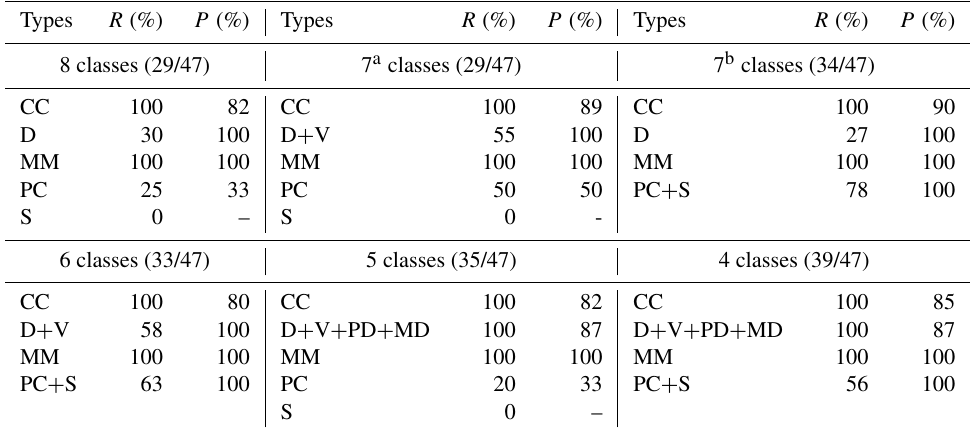
Table 6. Recall ( R ), and precision ( P ) estimated from the classification matrices for 8, 7 a , 7 b , 6, 5, and 4 classes. The values between parentheses correspond to the number of layers passed the screening criteria.